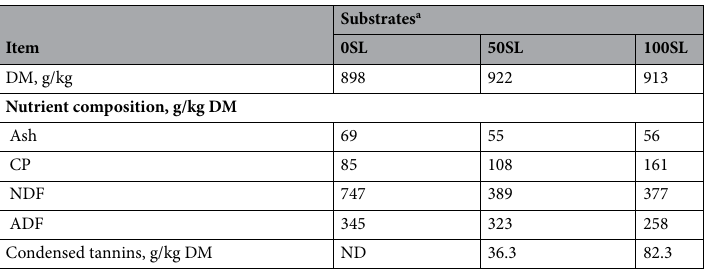
Table 4. Chemical composition of substrates used in in vitro incubations of Trial 1. ND, not detected. a SL: sericea lespedeza [ Lespedeza cuneata (Dum. Cours.) G. Don]; 0SL: 0% (fresh weight basis) sericea lespedeza hay (100% bermudagrass hay); 50SL: 50% sericea lespedeza hay + 50% bermudagrass hay; 100SL: 100% sericea lespedeza hay (0% bermudagrass